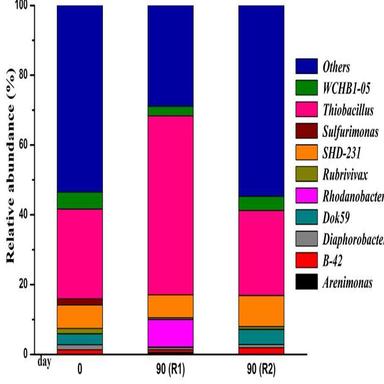
Microbial communities of sludge at genus.